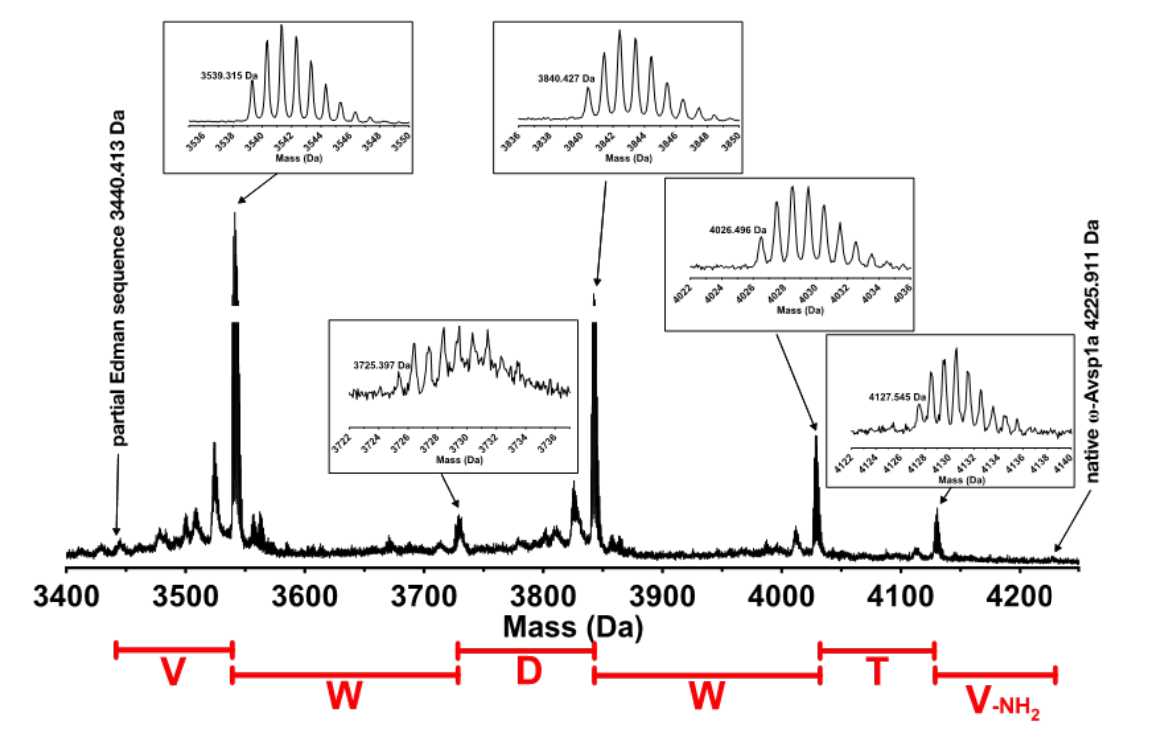
Figure 2. C-terminal sequencing of ω -Avsp1a after incubation with CBY for 60 min. Insets show zoomed spectra for the relevant fragments. The C-terminal sequence obtained from this data is indicated in red. All molecular masses are presented as [M + H] + .